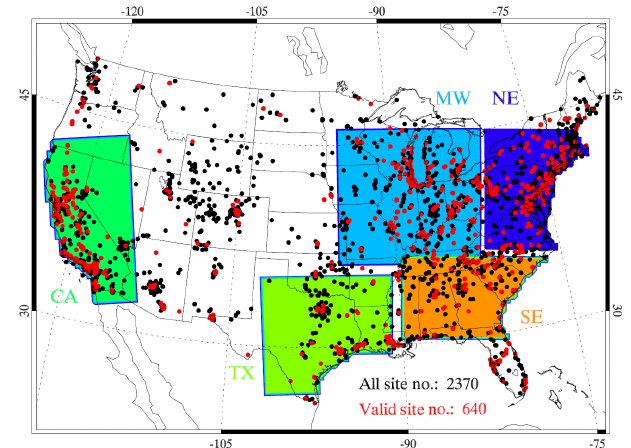
Figure 1. Locations of EPA AQS sites for surface ozone monitoring during 1990–2015. Red dots stand for monitoring sites with records of more than 20 years. Black dots show the locations of monitoring sites have short data records, which are not used in this study. The map shows the CWRF-CMAQ 30km domain and five subdomains sensitive to air pollution. CA: California (including nearby parts of Nevada, Arizona and Oregon); TX: Texas (including nearby parts of Louisiana, Arkansas and Oklahoma); SE: Southeast; NE: Northeast; and MW: Midwest. Please note that our CA and TX subdomains include more area than the states of California and